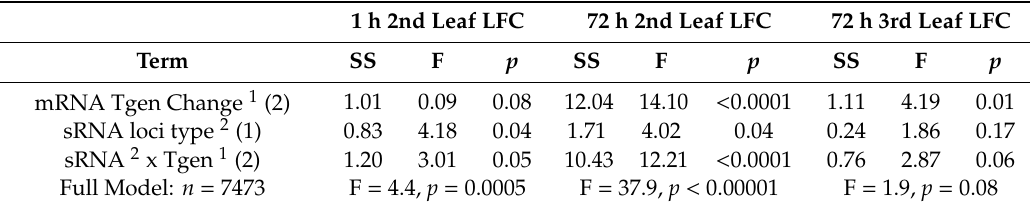
Table 2. Models linking sRNA LFC and mRNA transgenerational